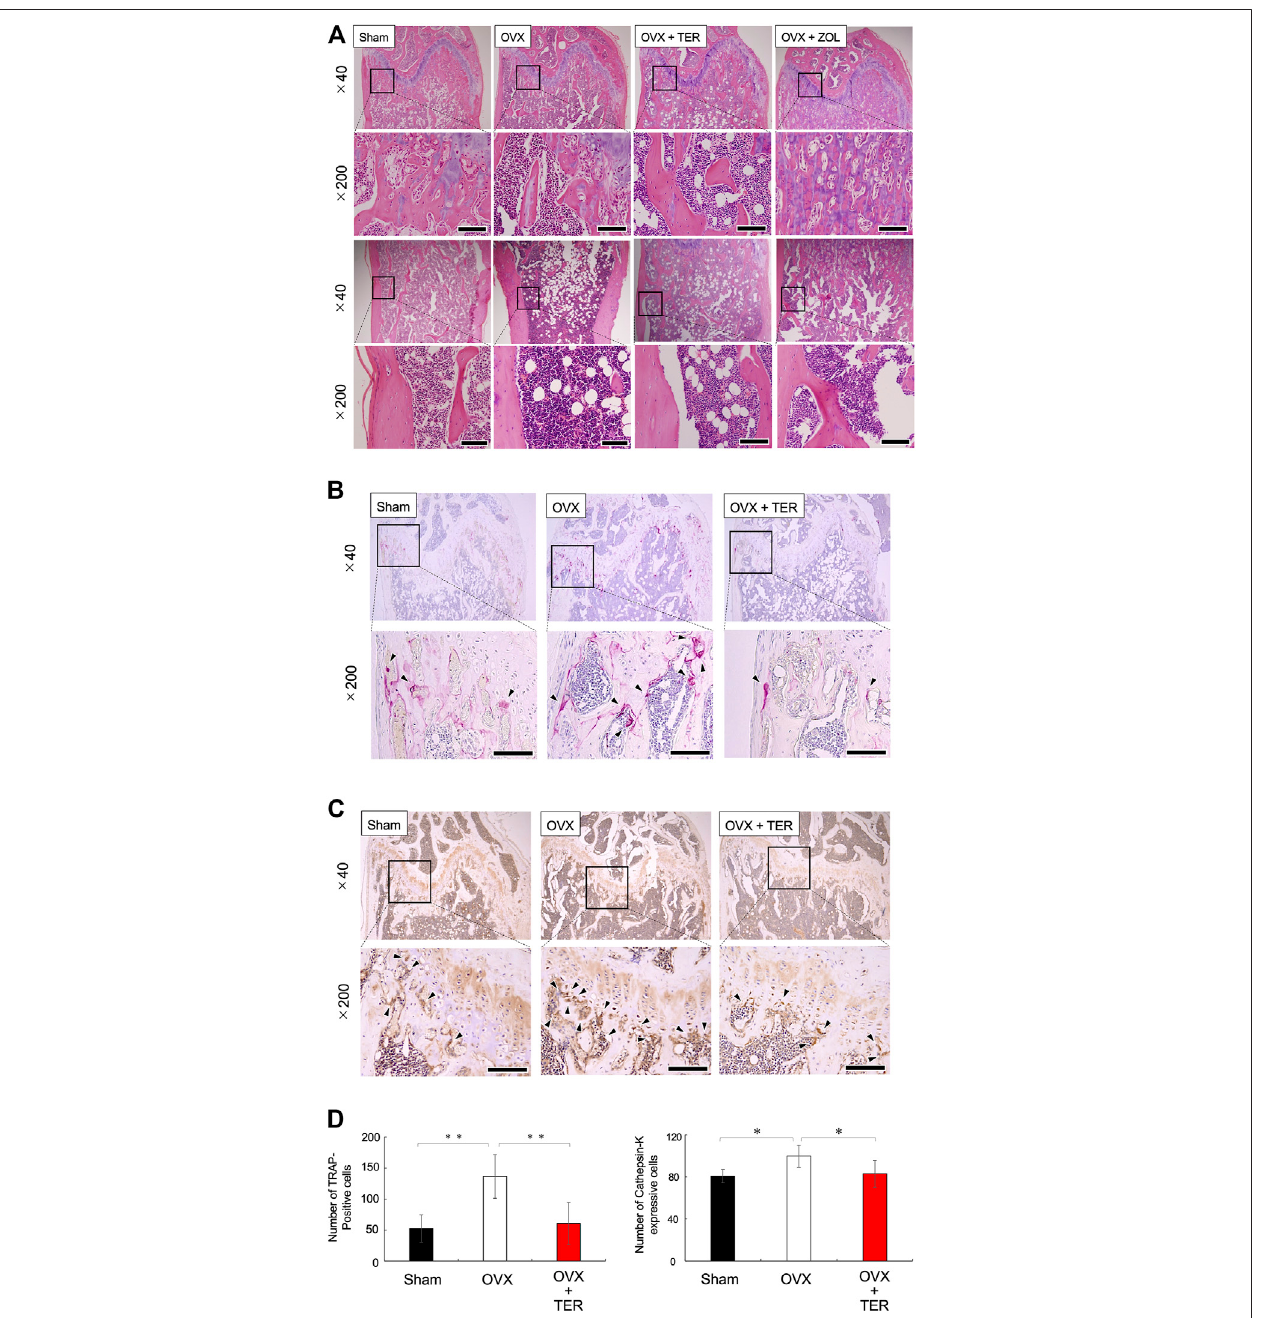
FIGURE 4 | Synthetic TER suppressed osteoclast differentiation. Representative histological images of (A) HE-stained, (B) TRAP-stained (osteoclast), and (C) anti – cathepsin-Kantibody – stainedcellsineachgroupareshown.TheenlargedimageoftheareaenclosedintheblacklineframeoftheHE-stainedimageisshowninthe lower row. Numbers next to the images indicate the magni fi cation; scale bar: 500 µm (at a × 40 magni fi cation) and 200 µm (at a × 200 magni fi cation). (D) The number of osteoclasts on the femur bone was measured ( n (cid:1) 3, mean ± SD, ** p < 0.01, ANOVA/Tukey – Kramer test) by de fi ning the osteoclasts as cells that were TRAP positive and which had more than three nuclei. The number of positive cathepsin-K – expressing cells on the femur was measured ( n (cid:1) 3 – 4, mean ± SD, * p < 0.05, ANOVA/Tukey – Kramer test) by de fi ning positive cells as those with darker cathepsin-K staining around the cell nucleus. Error bars: SD; dots: measured values; PBS: phosphate-buffered saline; Sham: PBS-treated non-osteoporosis mouse; OVX: PBS-treated osteoporosis mouse; OVX + TER: TER-treated osteoporosis mouse.